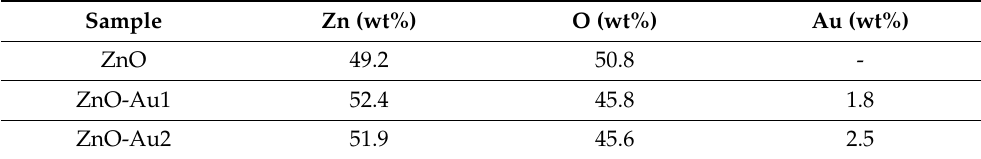
Figure 3. TEM images representing the ZnO nanoparticles ( a ) and the ZnO-Au nanocomposites (ZnO-Au1—( b ) and ZnO-Au2—( c )), together with their corresponding sizes and volume fraction distributions. Table 2. Elemental composition of ZnO-Au nanocomposites determined through EDX analysis.